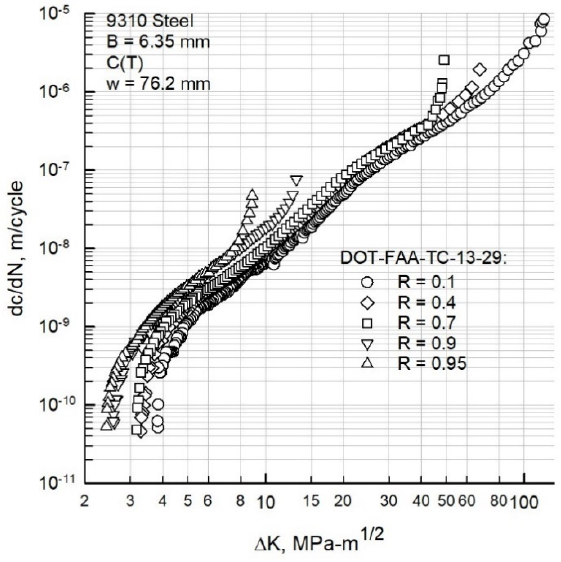
Figure 7. Stress-intensity-factor range against rate for 9310 steel over range in stress ratio (R).